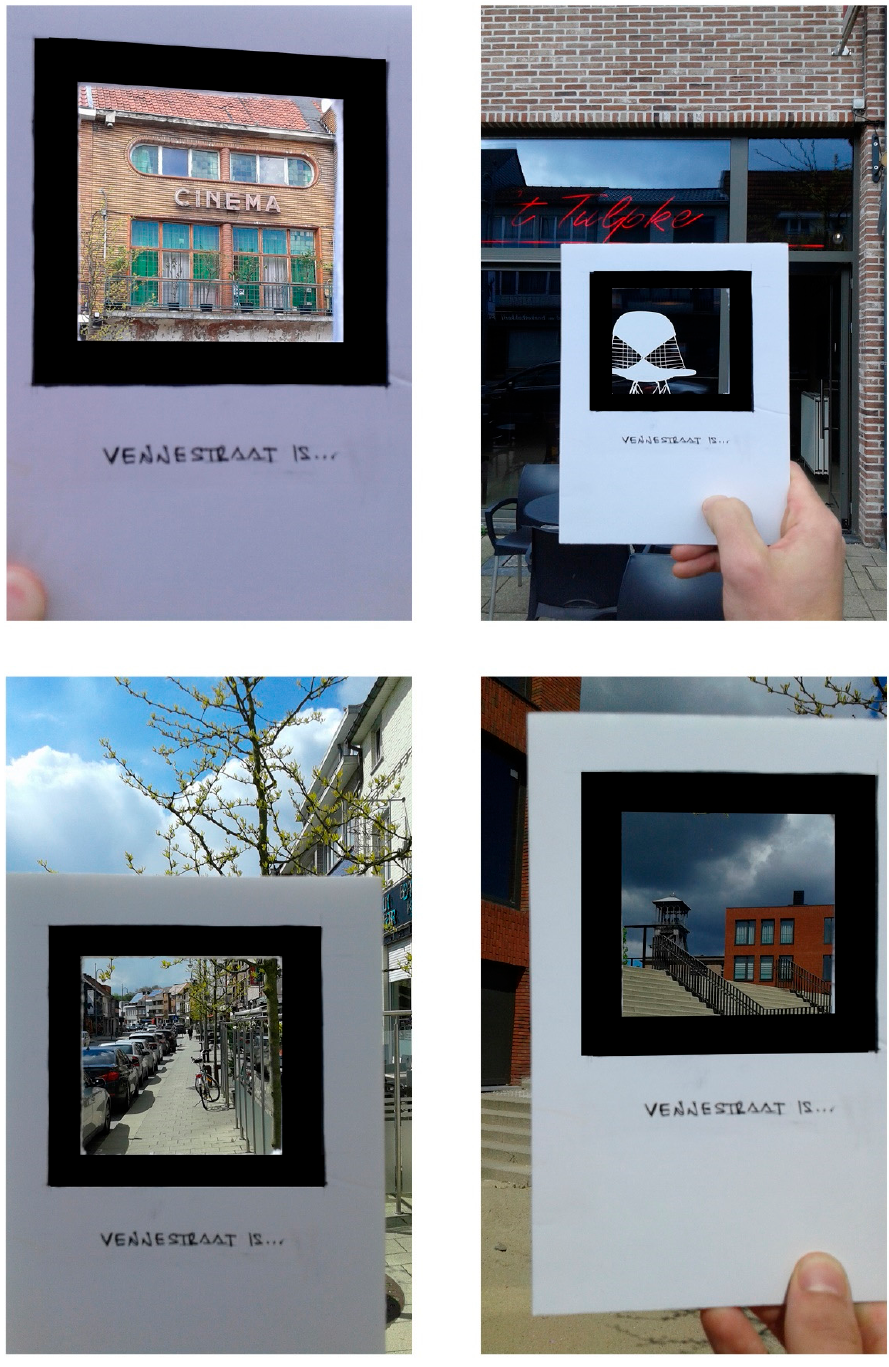
Figure 3. Mental Figure 3. Mental images.